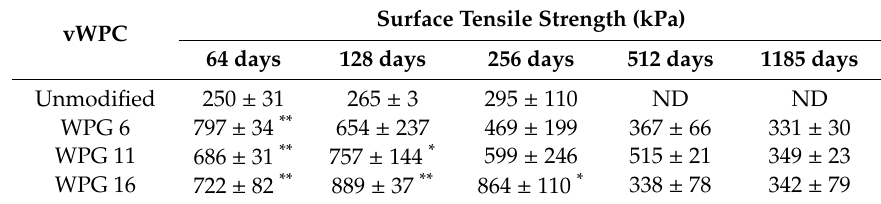
ND: not detected. Values are the mean ± SEM ( n = 3). * : p < 0.05; ** : p < 0.01 (one-tailed test) compared to the “unmodified”